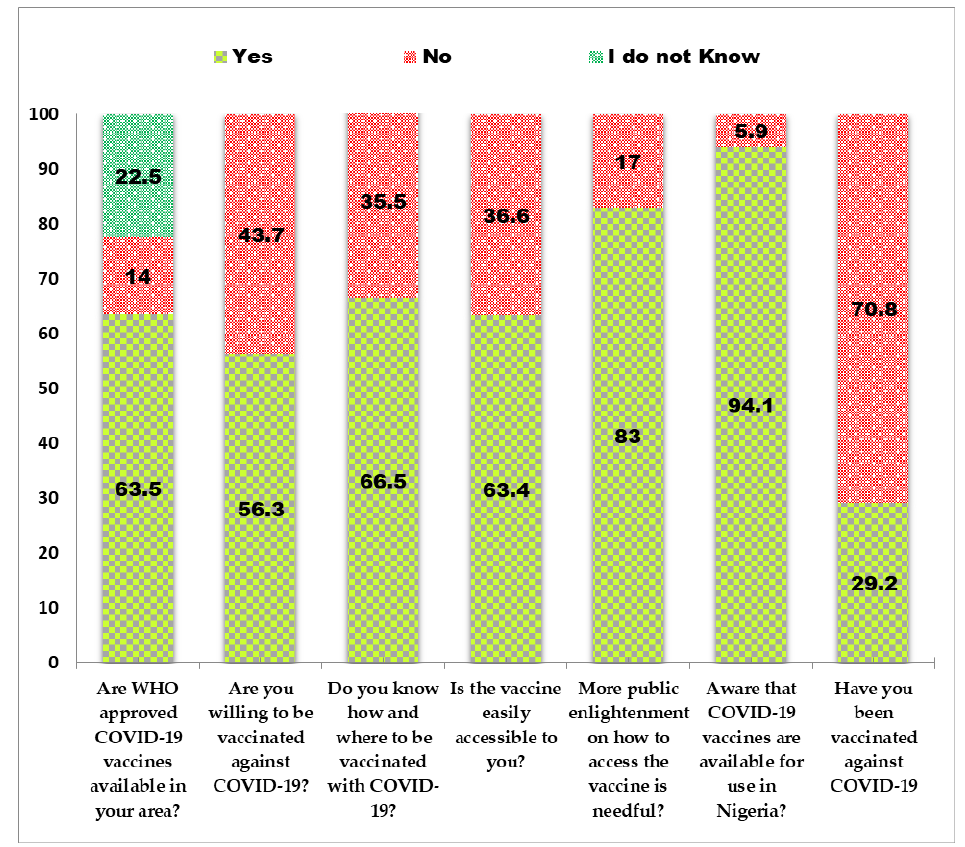
Figure 6. COIVD-19 vaccine availability, accessibility, acceptance, and hesitancy among healthcare workers, academics, and tertiary students in Nigeria. Vaccines 2022 , 10 , x FOR PEER REVIEW